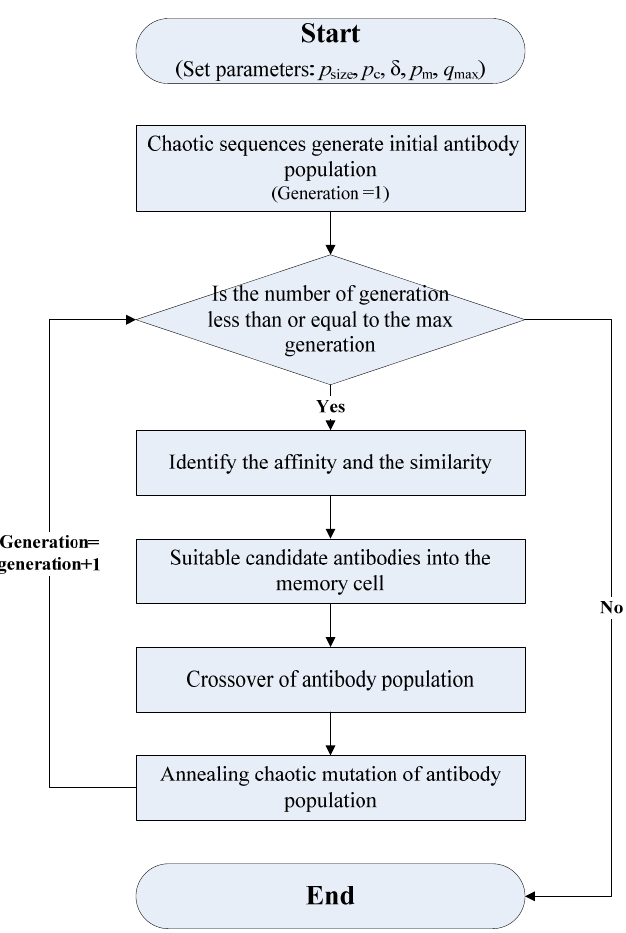
Figure 1. Chaotic immune algorithm (CIA)